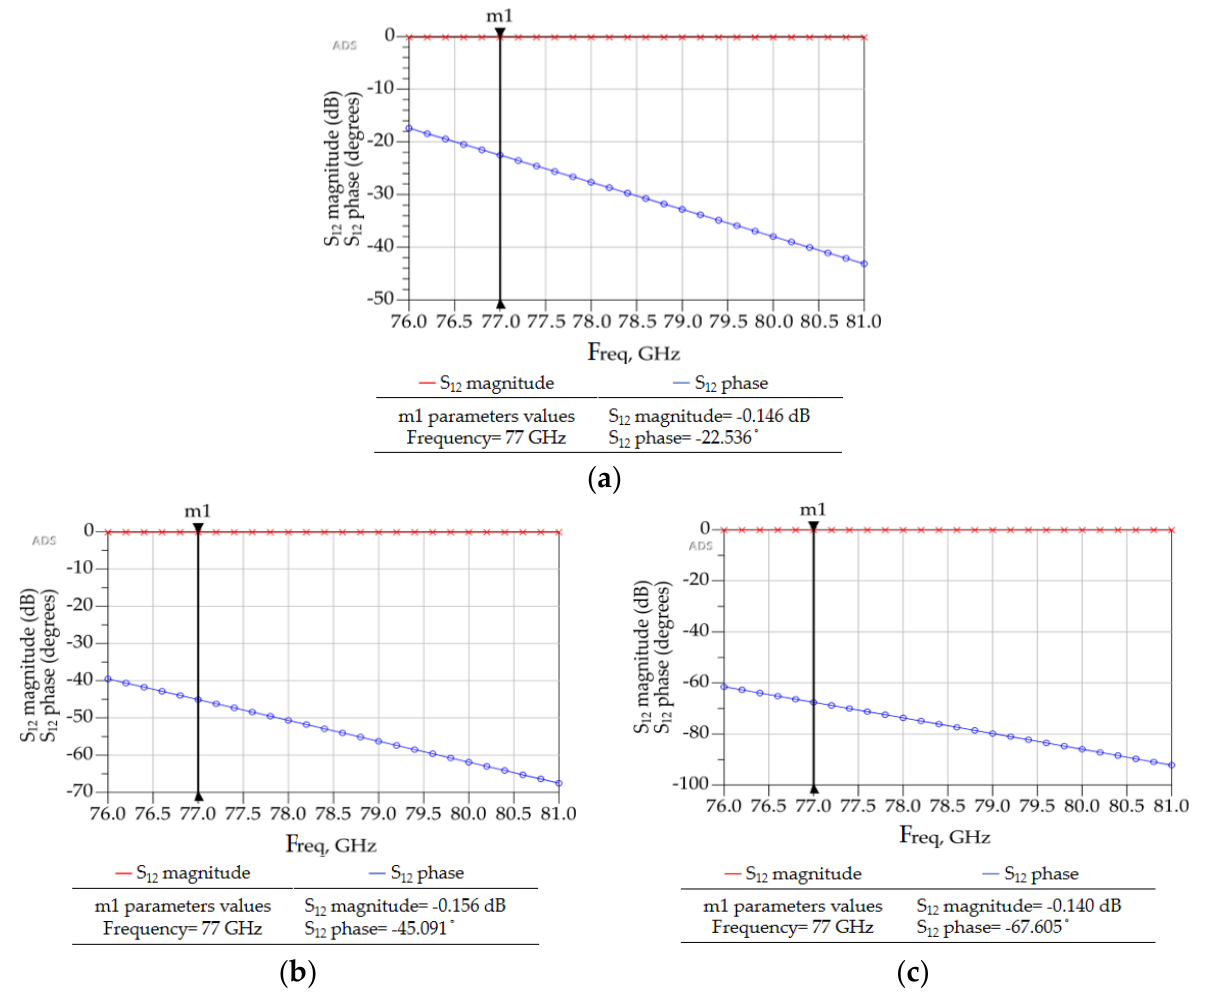
Figure 13. ADS generated 3D FEM simulation results for ( a ) a 22° phase shifter, ( b ) a 45° phase shifter, and ( c ) a 67.5° phase shifter.